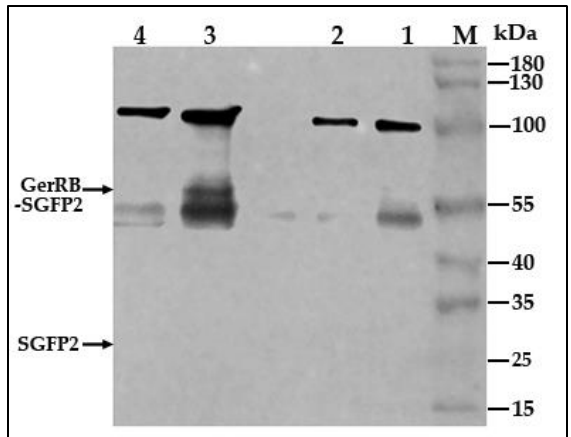
Figure 7. Analysis of GerRB-SGFP2 fusion protein expression in B. cereus spores of various strains. thirty micrograms protein in extracts from dormant spores of various B. cereus strains were separated on a 10% SDS-PAGE gel and western blots were probed with rabbit polyclonal anti-GFP antibody as described in Methods. The black arrow indicates the position of the expected 69 kDa GerRB-SGFP2 protein. Two nonspecific bands of ~100 kDa and ~55 kDa were also detected in all extracts. Notably, free SGFP2 at 27 kDa was not detected, in particular in extracts of spores carrying pHT315- P gerR - gerRB - SGFP2 . The extracts run in the various lanes were from: lane 1, wild-type spores; lane 2, spores carrying pHT315; lane 3, spores carrying pHT315-P gerR - gerRB - SGFP2 ; lane 4, spores carrying pHT315- gerRB - SGFP2 ; lane M, prestained protein